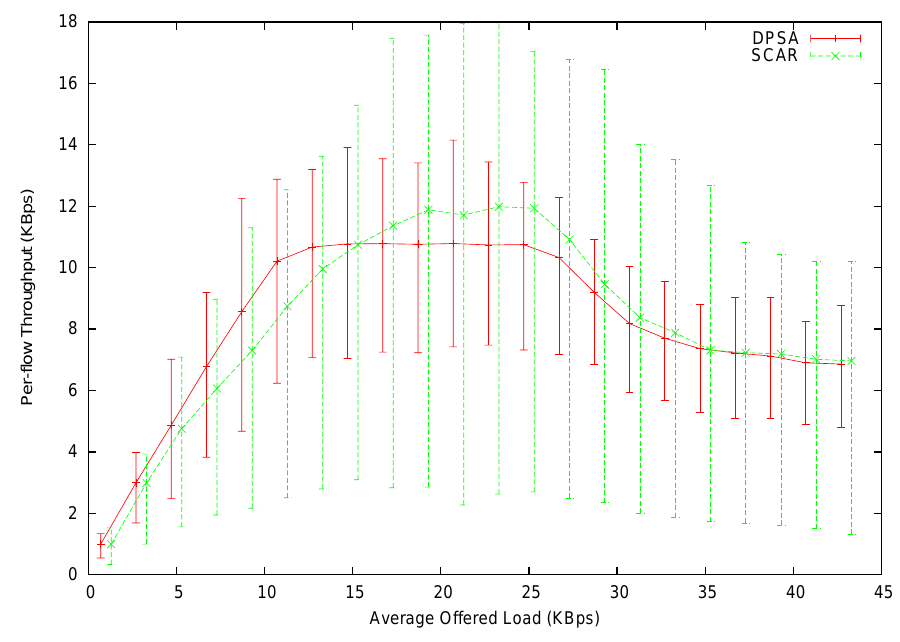
Figure 12. Per-flow throughput in Experiment